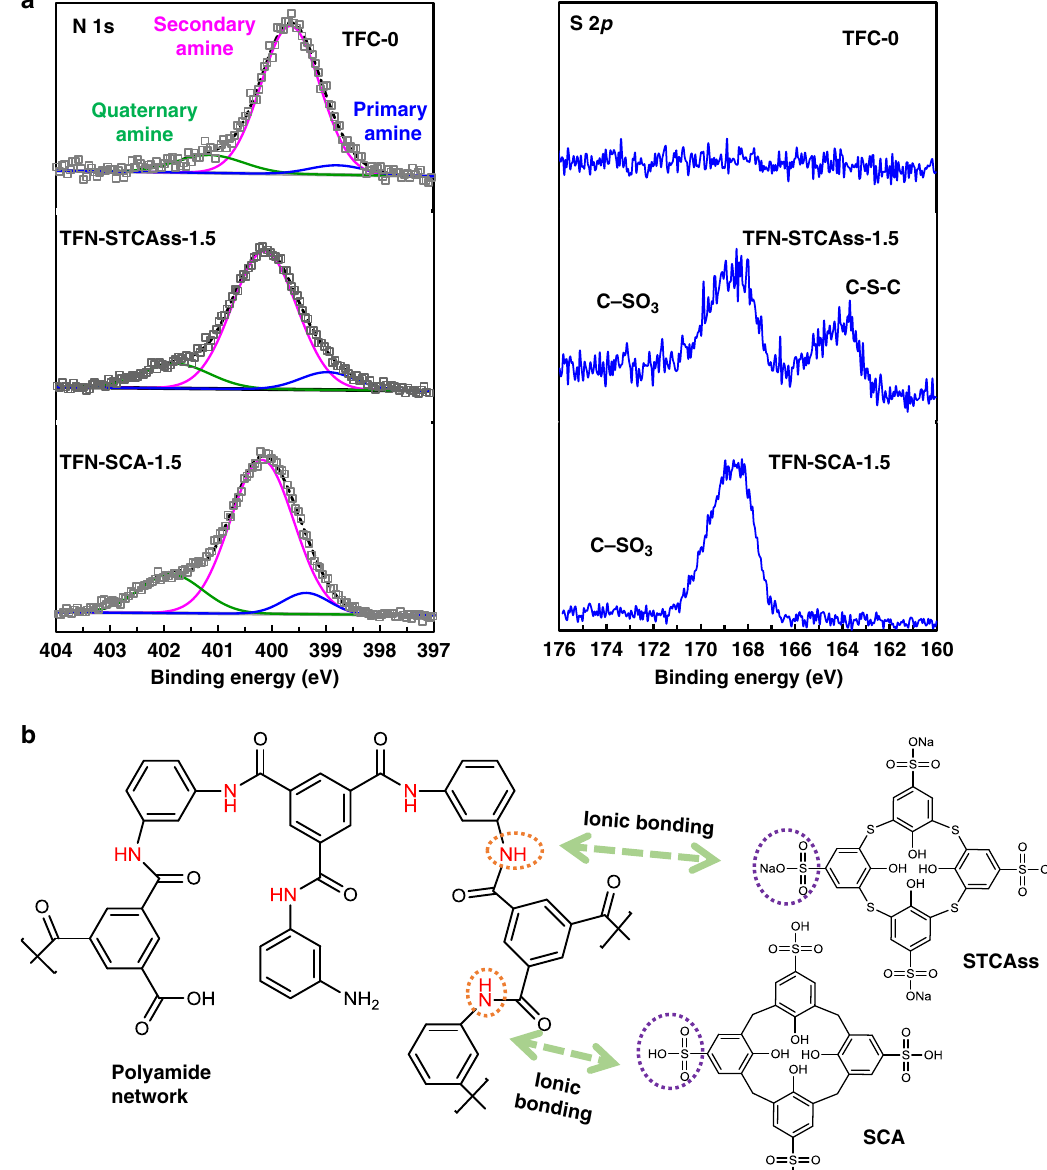
Fig. 4 Ionic interactions between the polyamide network and STCAss/SCA. a Deconvolution of N 1 s and S 2 p XPS spectra for TFC-0, TFN-STCAss-1.5, and TFN-SCA-1.5, and b illustrations on the interactions between polyamide network and